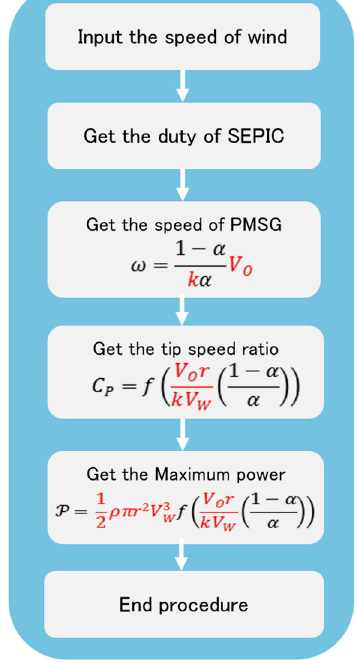
Figure 13. WECS simulation modeling flow chart